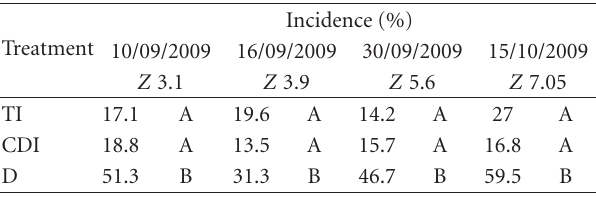
recorded during August and October (last ten days) and two days in November (second ten days).